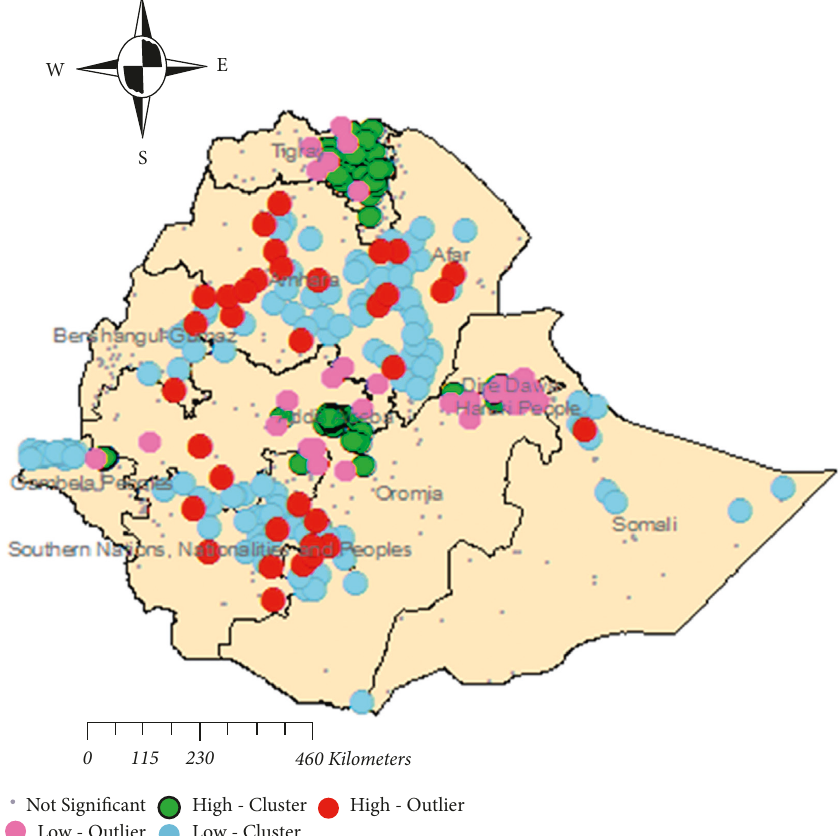
Figure 4: Cluster and outlier of institutional delivery in Ethiopia, 2016 (source: shape file from CSA, 2013, done using ArcGIS version